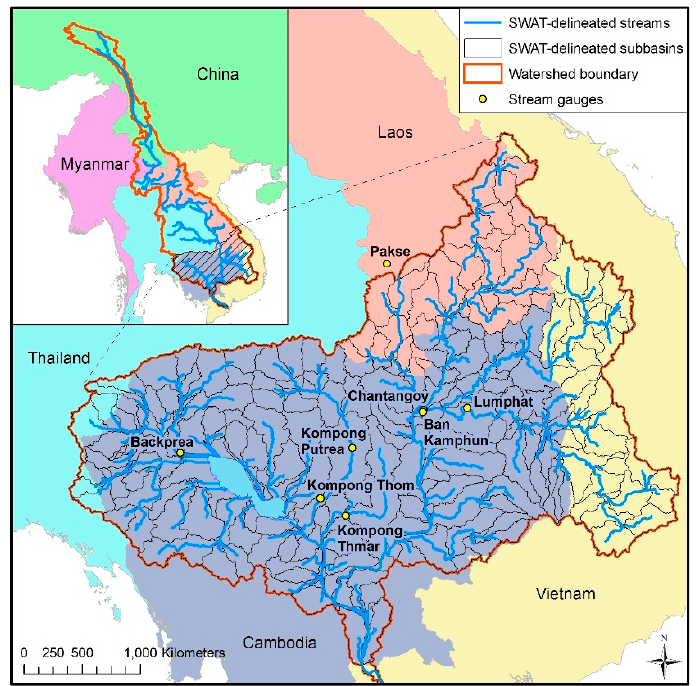
Figure 2. Study area showing the SWAT-derived basin and sub-basins. The map also shows the location of the Mekong River Commission gauges used in the modeling and calibration of the